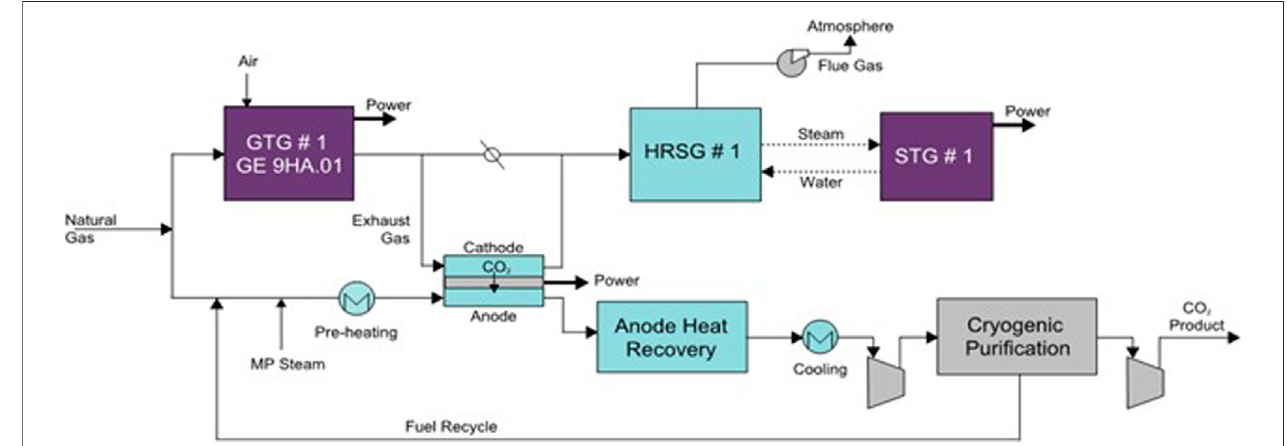
Frontiers in Energy Research |